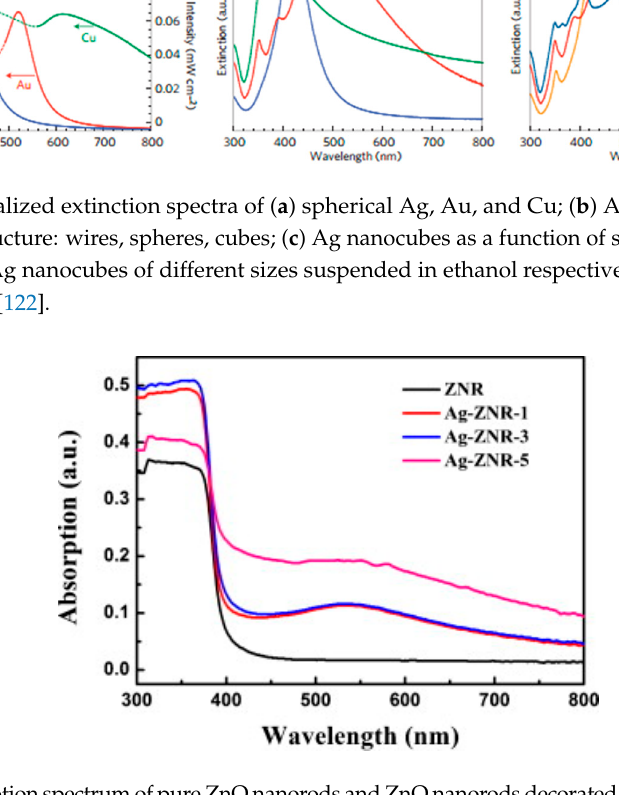
46 of 53 Figure 71. Finite difference time domain (FDTD) simulation of electric field intensity spatial